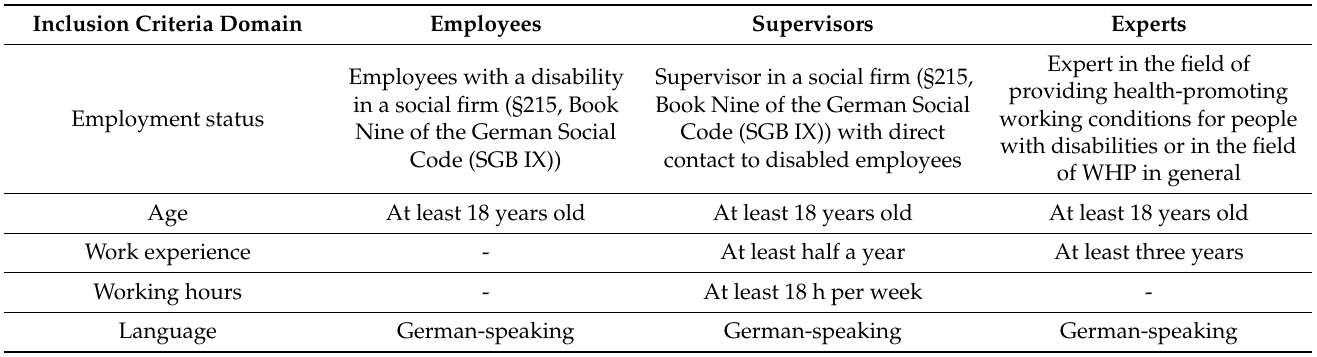
Table 2. Applied inclusion